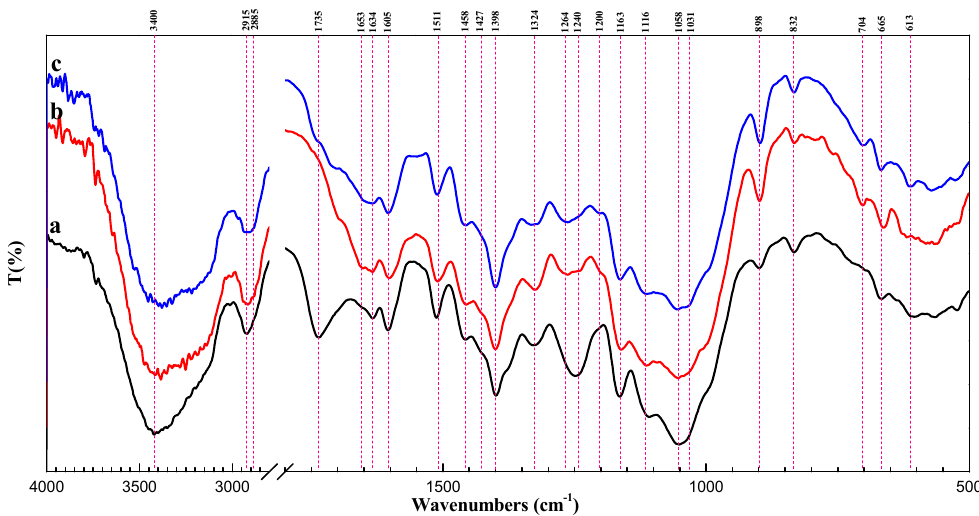
Figure 1. FT-IR spectra of SCB ( a ), fresh SCB-NH 2 ( b ), and recovered SCB-NH 2 ( c ).